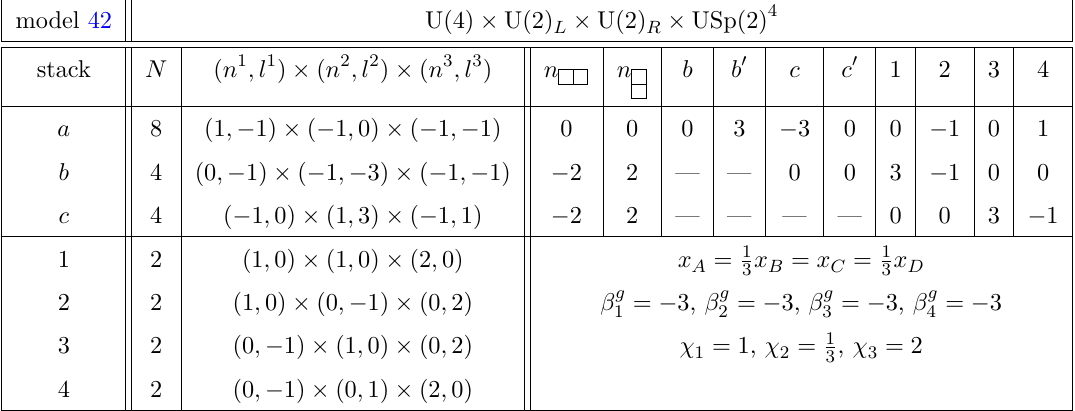
Table 42 . D6-brane configurations and intersection numbers of Model 42, and its MSSM